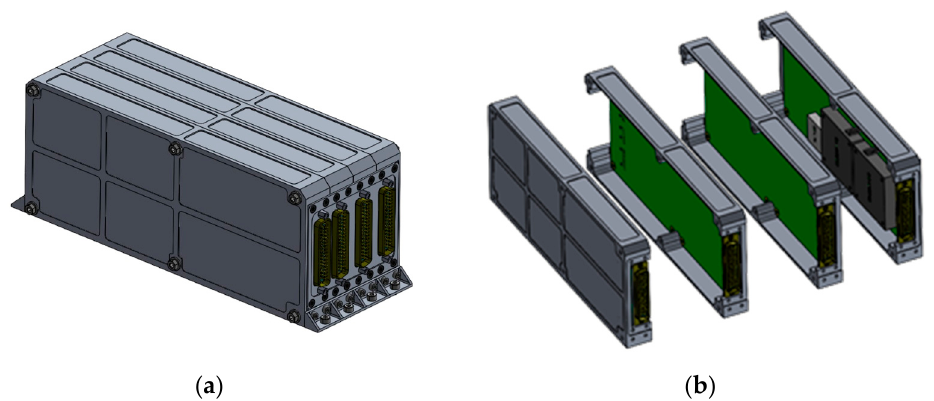
Figure 16. ( a ) External configuration and ( b ) exploded view of the S-STEP PSU.